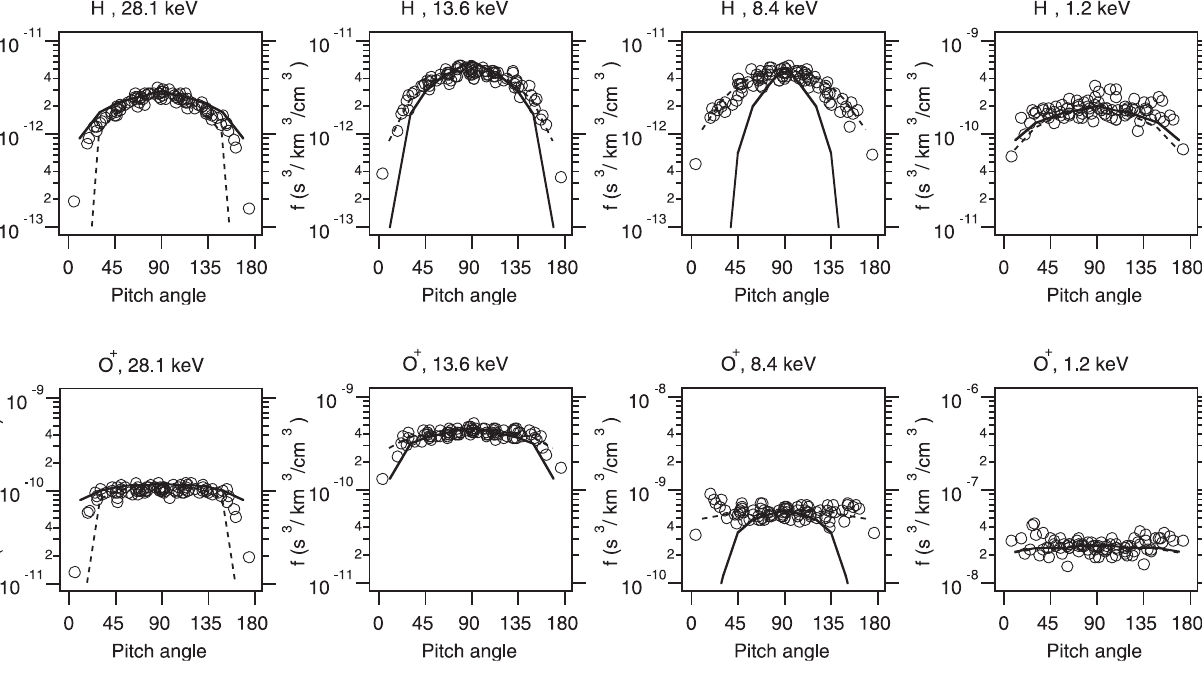
Fig. 10. Comparisons of observed and modeled pitch angle distributions using the Volland-Stern electric field ( solid line ) and the Weimer electric field ( dashed line ) assuming an initial isotropic distribution and charge exchange as the only